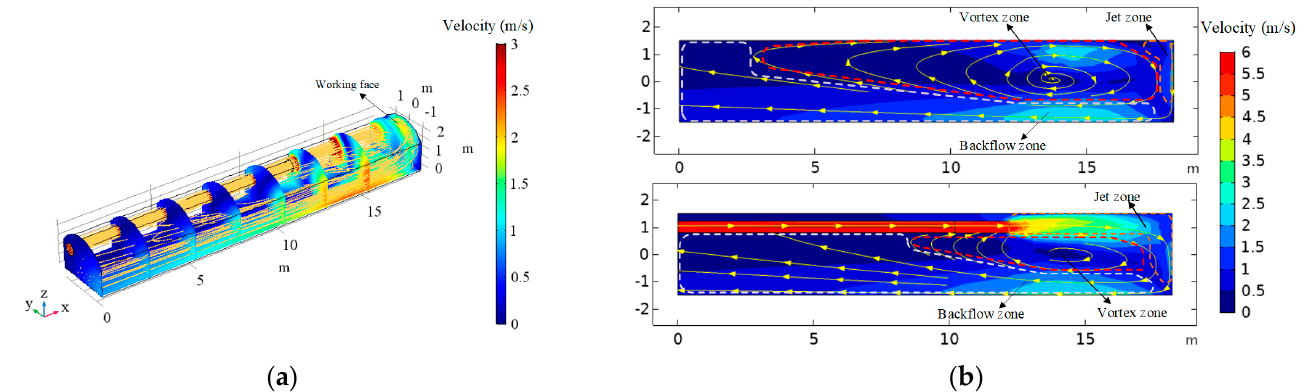
Figure 3. Air flow velocity distribution in the roadway: ( a ) air velocity isoclines in the Y direction; ( b ) airflow field in the different Z plane.